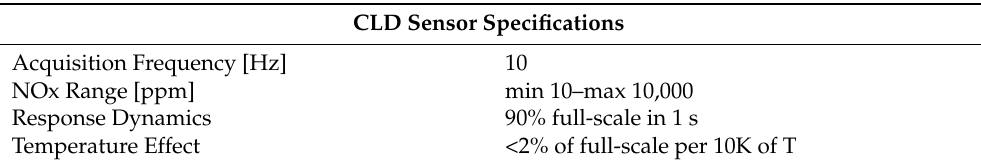
Table 2. Chemiluminescent Detector Sensor (CLD)